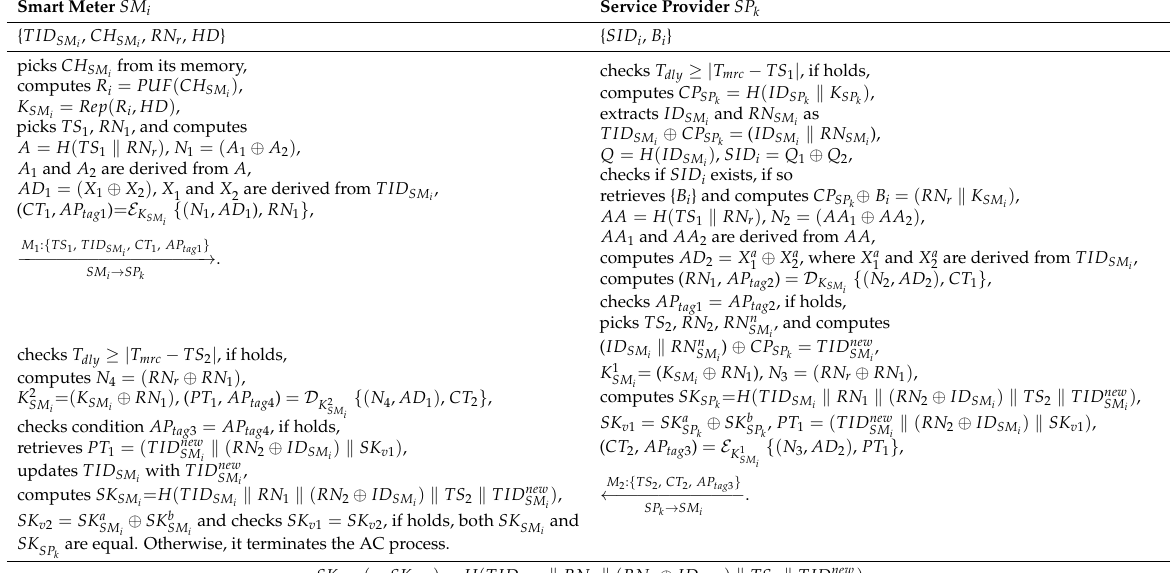
Figure 3. LACP-SG authentication